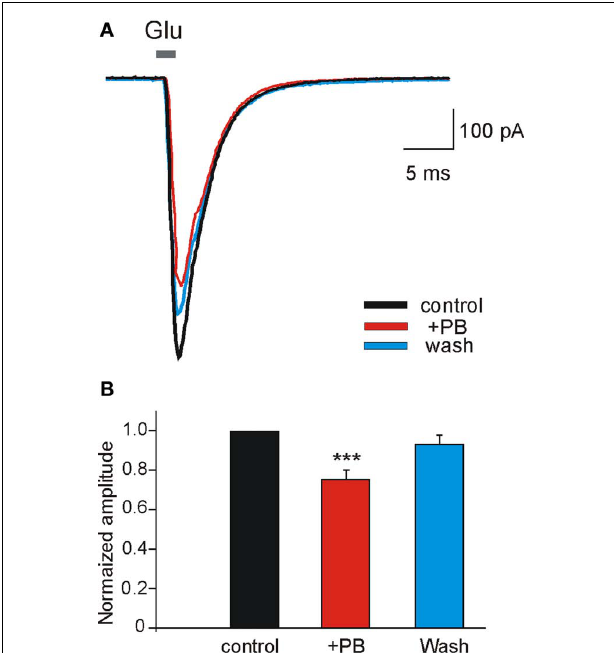
FIGURE 7 | Phenobarbital reducesAMPA receptor mediated currents in nucleated patches. (A) Currents evoked in nucleated patches from CA3 pyramidal neurons from control slices. L-Glutamate ( Glu , 1mM) was applied in 2ms pulses at a holding potential of − 60mV. Each trace is the average of 4–8sweeps. Note that PB [ (A) red trace] reduced the amplitude of AMPA/kainate mediated currents. (B) PB significantly reduced (by 25.5 ± 0.5%, p < 0.001, n = 8) the averaged amplitude of AMPA/kainate receptor mediated currents recorded in nucleated